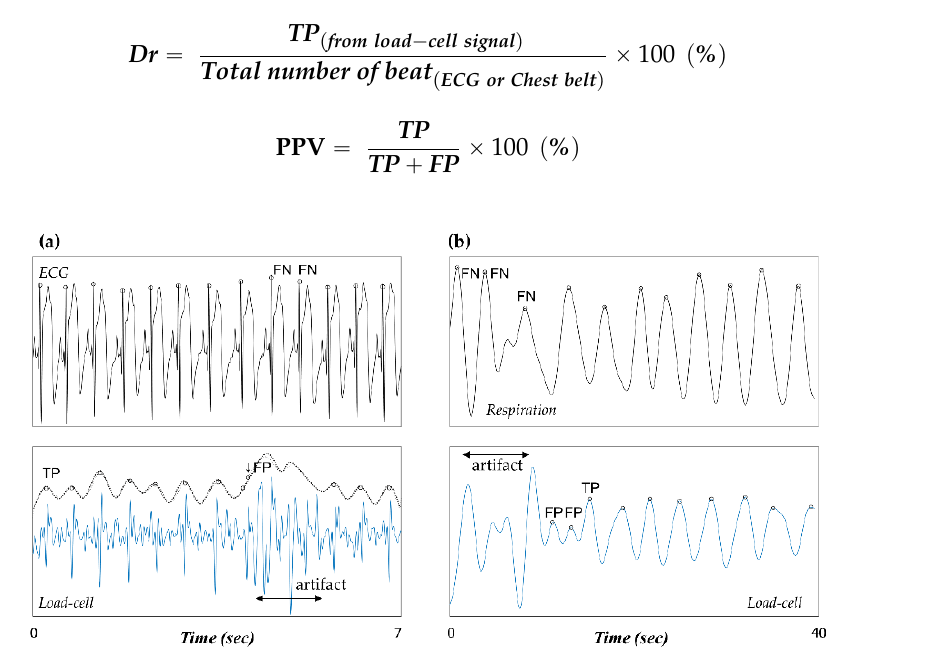
Figure 9. Manually annotated peak locations and automatic peak detection results of the load-cell sensor signal obtained by the developed algorithm in ( a ) HR analysis and ( b ) BR analysis (definitions of TP, FP, and FN are illustrated).